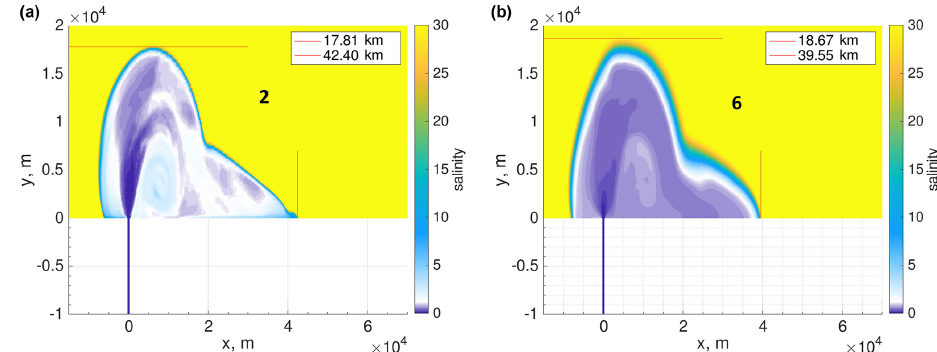
Figure A3. The surface salinity, in practical scale, at 35h as a result of runs 2 (a) and 6 (b) (see Table A1 for the run details).